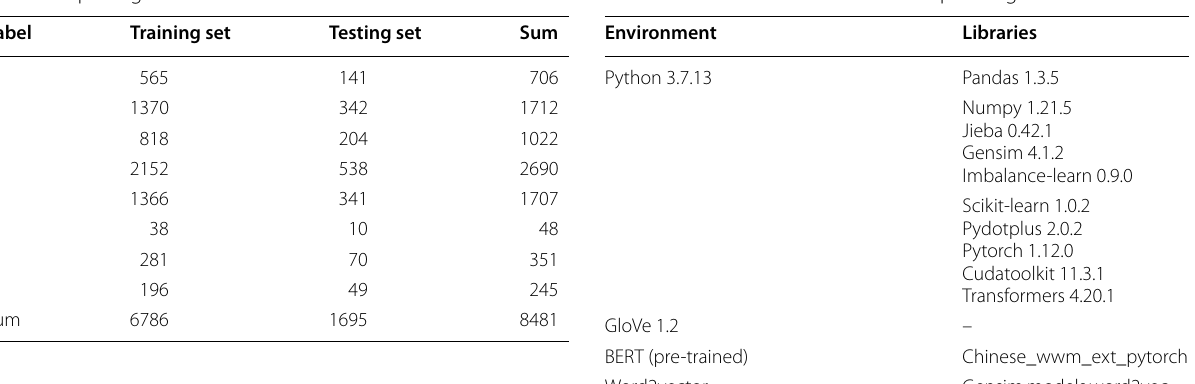
Table 8 The environment and corresponding libraries